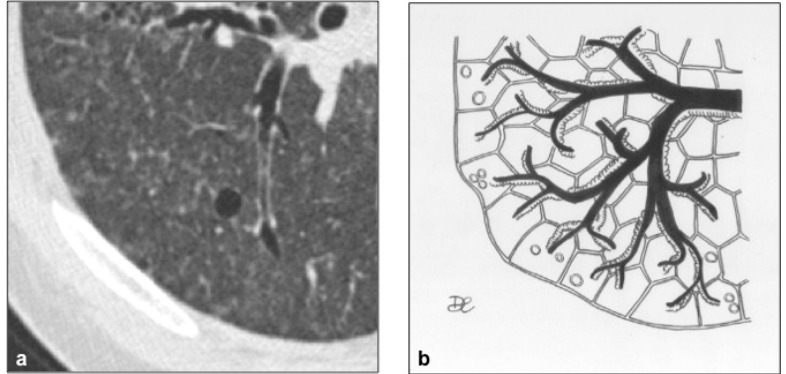
Figure 10. DIP cysts pattern ( a , b ). Lung cysts with regular shape, uniform size, thin walls, predominantly localized at the peripheral regions. This figure has been partially modified from ECR 2017 / C-2141 Cystic pattern in lung diseases: a simplified HRCT guide based on free-hand S. Palmucci. drawings, DC Caltabiano, V. Costanzo, L. Mammino, V. Vindigni, S. Torrisi, R. Rosso, LA Mauro,